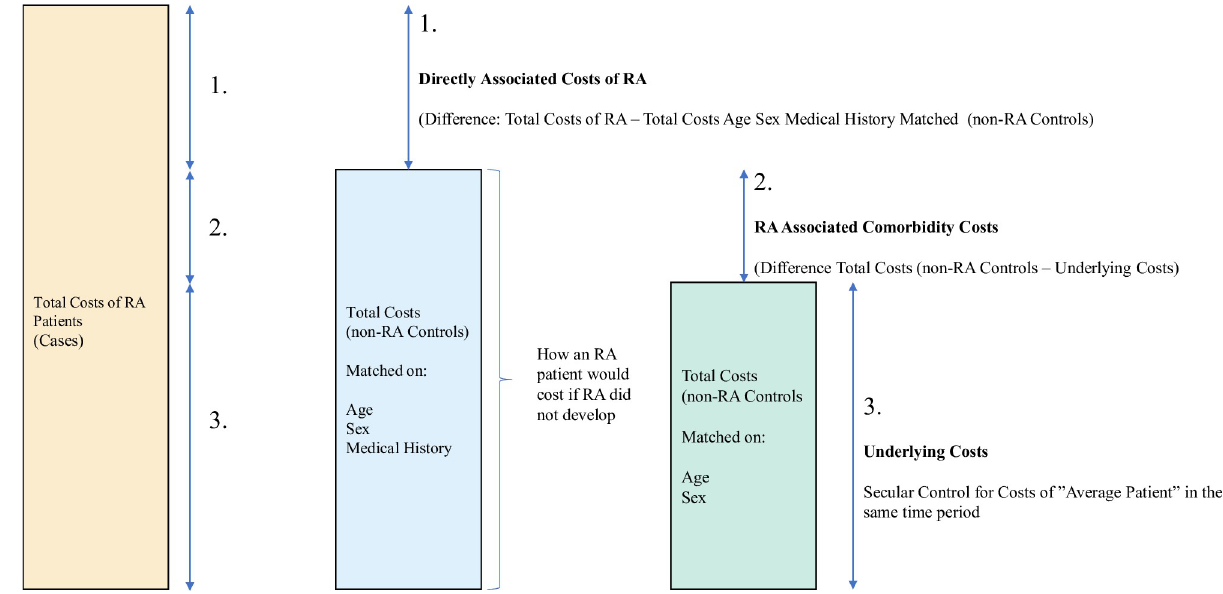
Fig 1. Statistical attribution mechanisms for the health care costs of RA. No